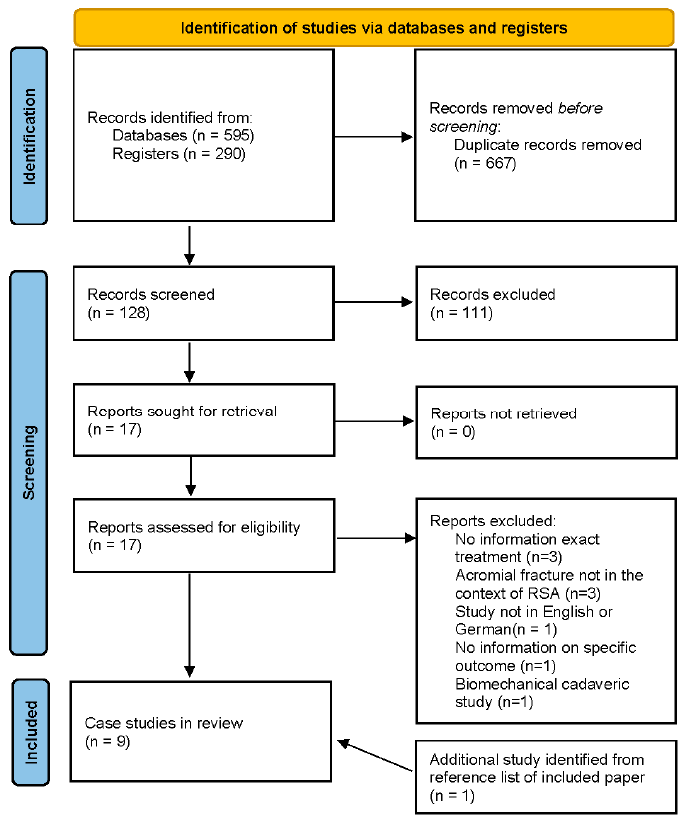
Figure 2. PRISMA flow diagram (updated version 2020) of the systematic search. RSA, reverse total shoulder arthroplasty.